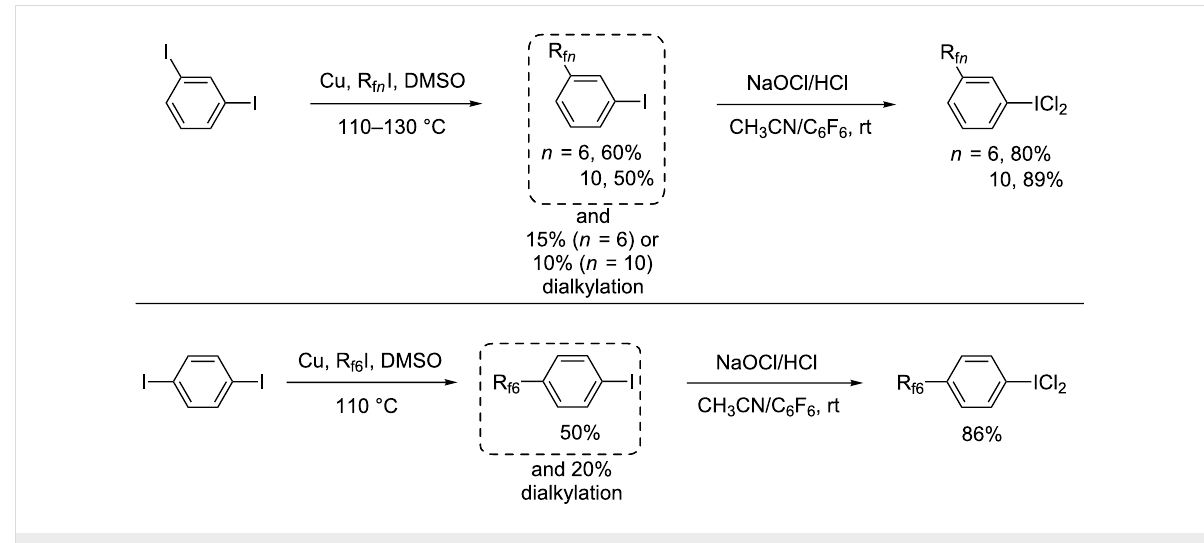
Scheme 5: Syntheses of aromatic fluorous compounds with one perfluoroalkyl